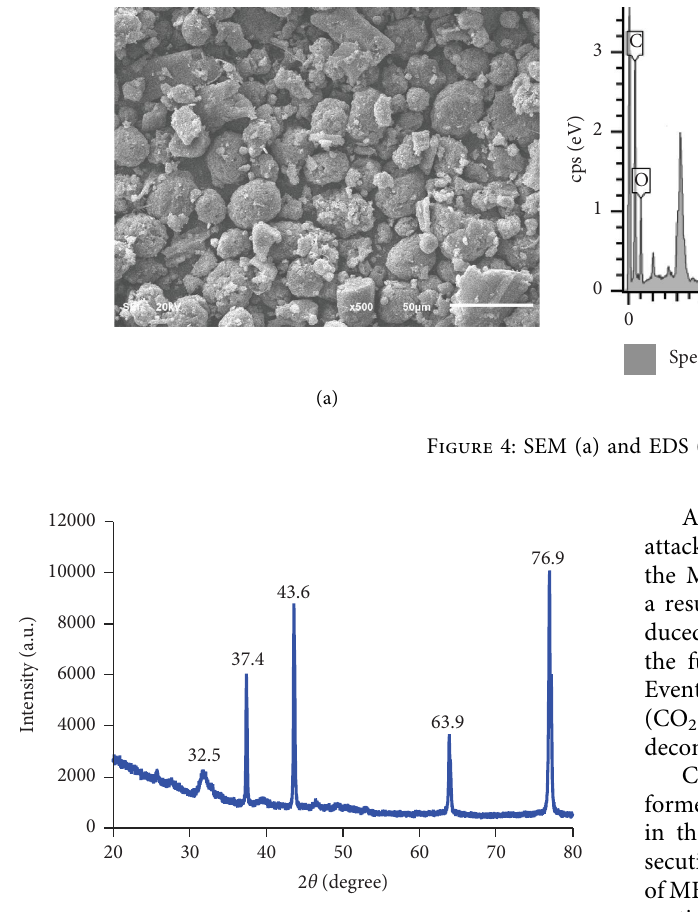
Figure 5: XRD pattern of